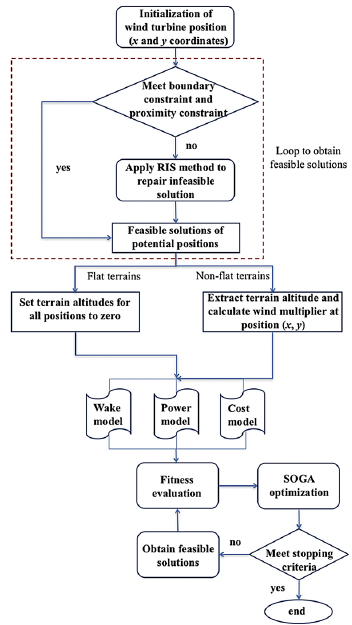
Figure 19. The optimisation process of wind farm layout in flat and non-flat terrains recommended by [97].